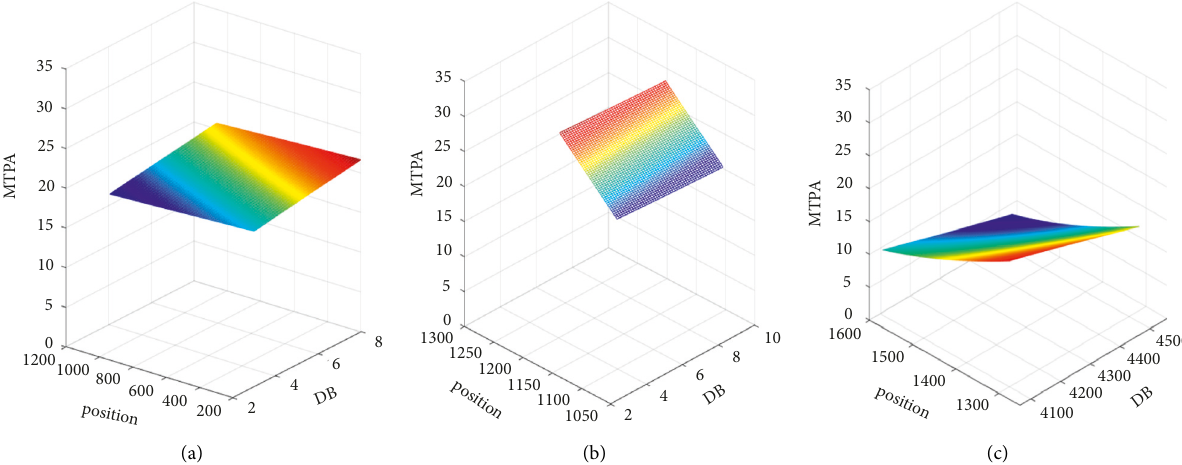
Figure 10: The influence of design brightness and position on MTPA in stages 3–5. (a) Stage 3. (b) Stage 4. (c) Stage 5.